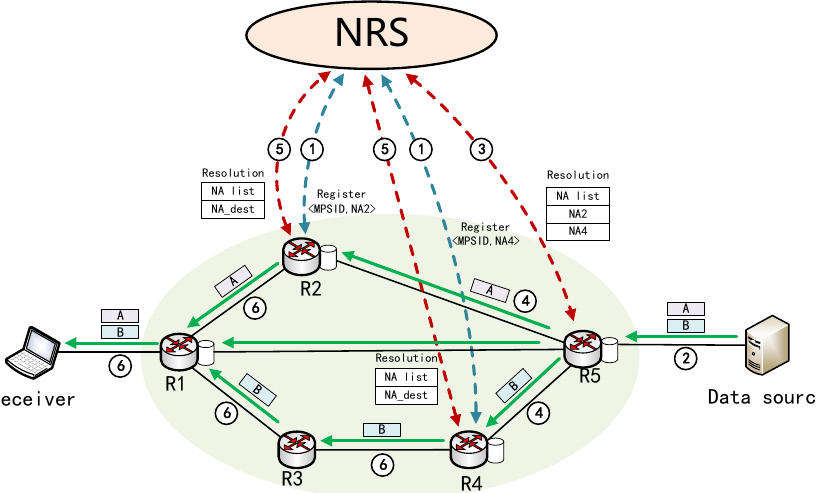
Figure 2. An overview of the multipath transmission process.